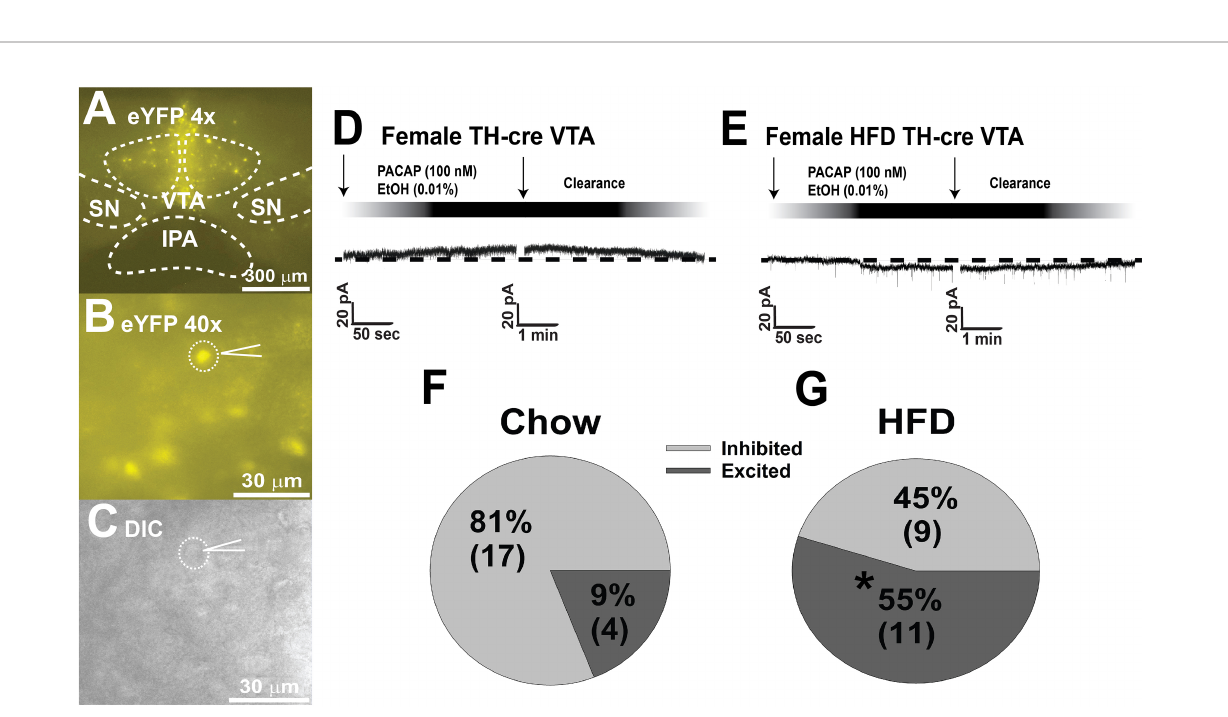
FIGURE 5 | DIO-induced alterations in the response pro fi le of A 10 DA neurons from OVX female TH-cre mice to the postsynaptic effect of PACAP. (A, B) enhanced yellow fl uorescent protein signal from A 10 DA neurons in VTA slices captured at 4X and 40X. (C) differential interference contrast image of the recorded A 10 DA soma seen in (B) . (D, F) PACAP (100 nM; n = 17) produces a reversible outward current in the considerable majority (17/21; 81% vs males): of A 10 DA neurons from lean, chow-fed females, which is very similar to the percentage of PACAP-inhibited A10 DA neurons seen lean, chow-fed males (21/24; 87%). (E, G) Conversely, PACAP (n = 11) exerts a more heterogenous response in A 10 DA neurons from obese, HFD-fed females, with the majority (11/20; 55%) of them being an excitatory inward current. Arrows indicate where I/Vs were conducted. *, p < 0.05; with respect to chow-fed controls, Chi-squared test.